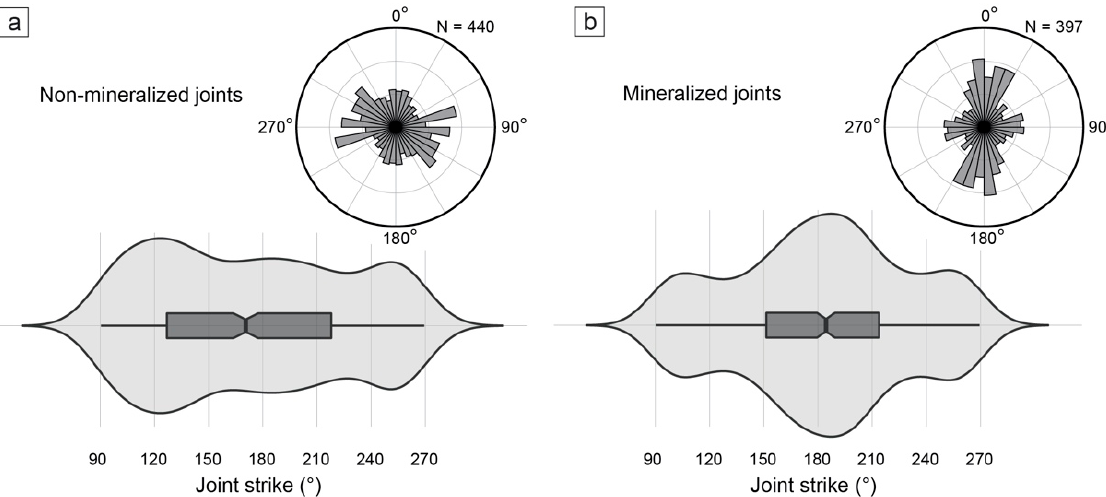
Figure 4. Joint strike measurements plotted as rose (top) and violin plots (bottom). Violin plots show probability density functions of the strike for each dataset. Peaks on a violin plot indicate the relative probability of observing a value given the distribution of the recorded data. The box plot inside each violin plot shows the range and median of our strike measurements. Rose plots show the frequency distribution of joint strikes for each data set in 10° bins. ( a ) Data plotted for non-mineralized joints. Non-mineralized joints show a preferred E − W orientation in the rose plot but the violin plots indicates an equal probability of striking in any direction with a slight preference of strikes around 120°. ( b ) Data plotted for mineralized joints. Mineralized joints show preferred N − S orientations as seen in the rose plot with the violin plot indicating a higher probability of striking between 150° and 210° than at any other azimuths.